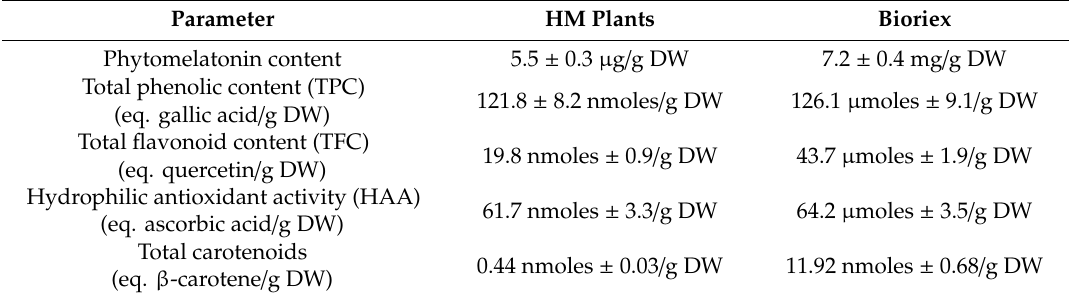
Table 3. Specific analysis of herbal mix (HM) and final product